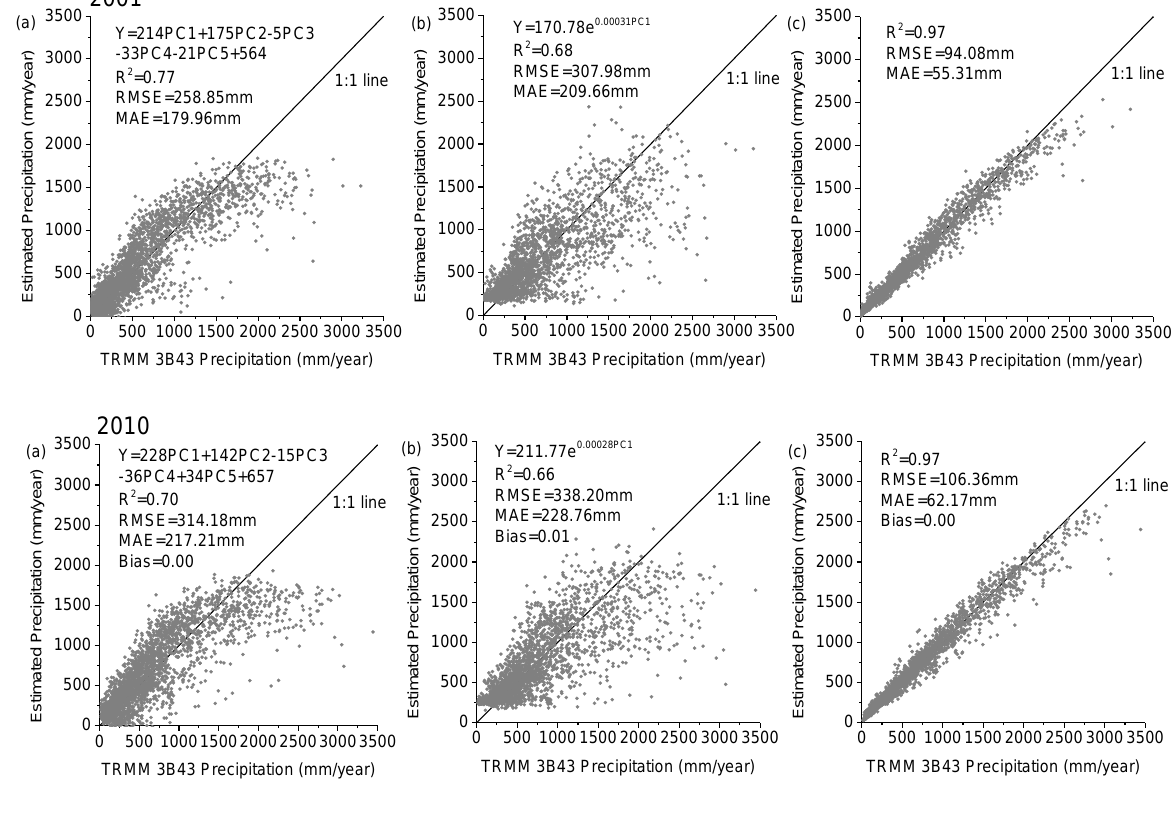
Figure 3. Scatter plots of the agreements between the annual precipitations of China mainland for the year of 2001 and 2010 derived from the TRMM 3B43 and ( a ) the multiple linear regression model, ( b ) exponential regression model, and ( c ) random Forest model at spatial resolutions of 0.25°,